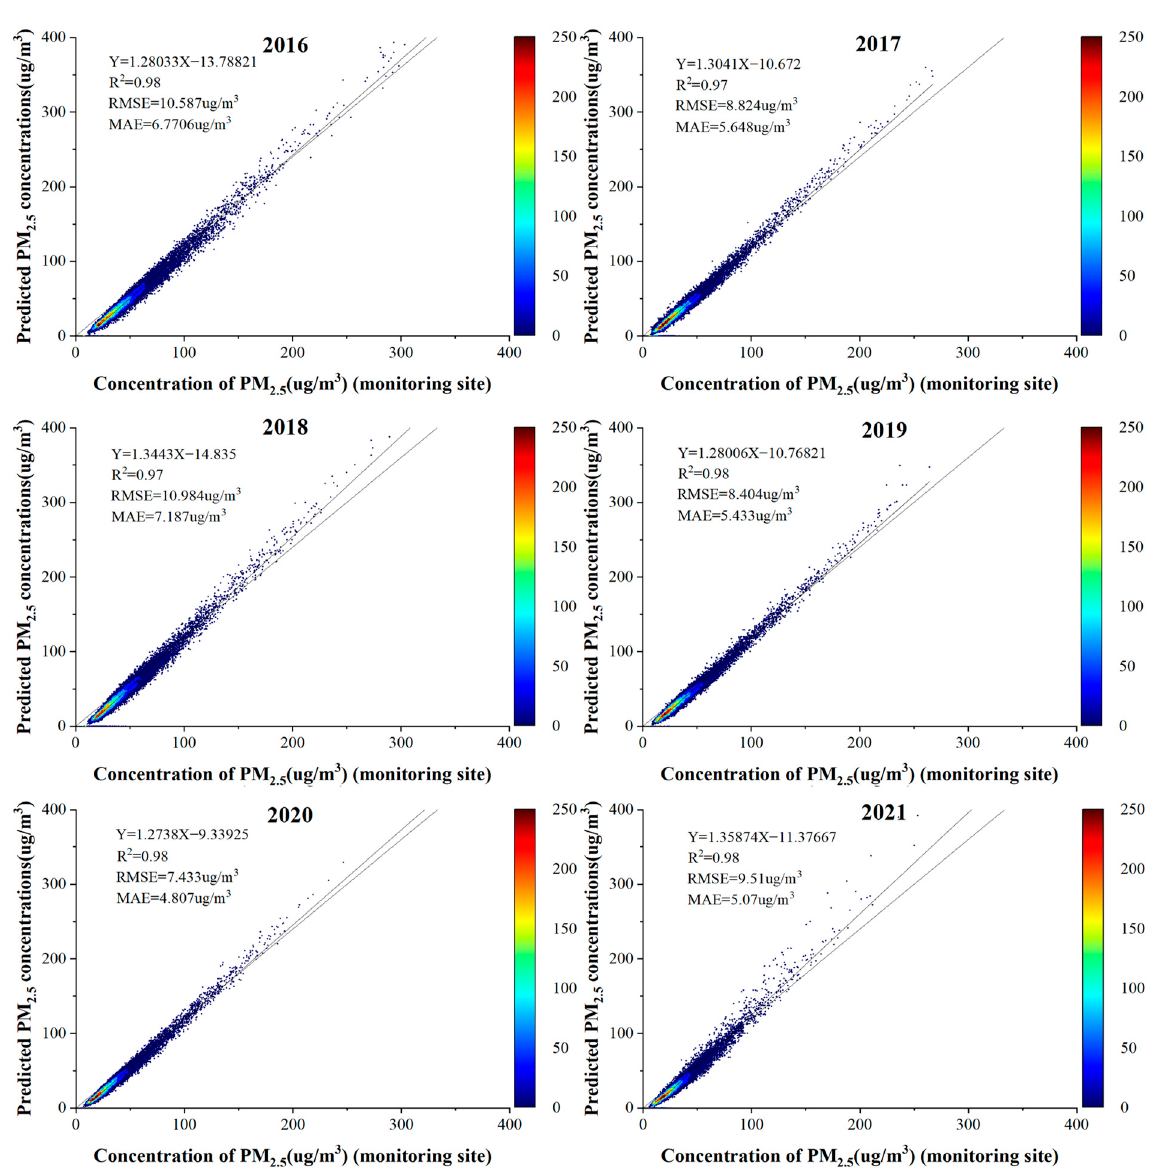
Figure 6. PM 2.5 concentration simulation 2016–2021 scatter density map.